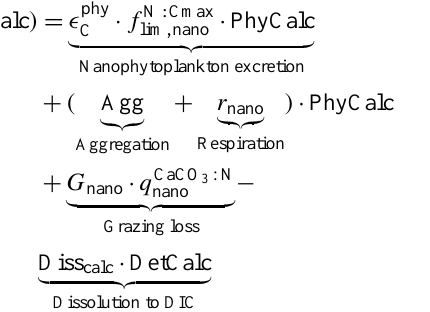
Table A1. The limiter function ( f N:Cmax ) is described in lim Sect. A6.1. The aggregation rate (Agg) is calculated in Eq. (A27), the respiration rate ( r nano ) in Eq. (A45)